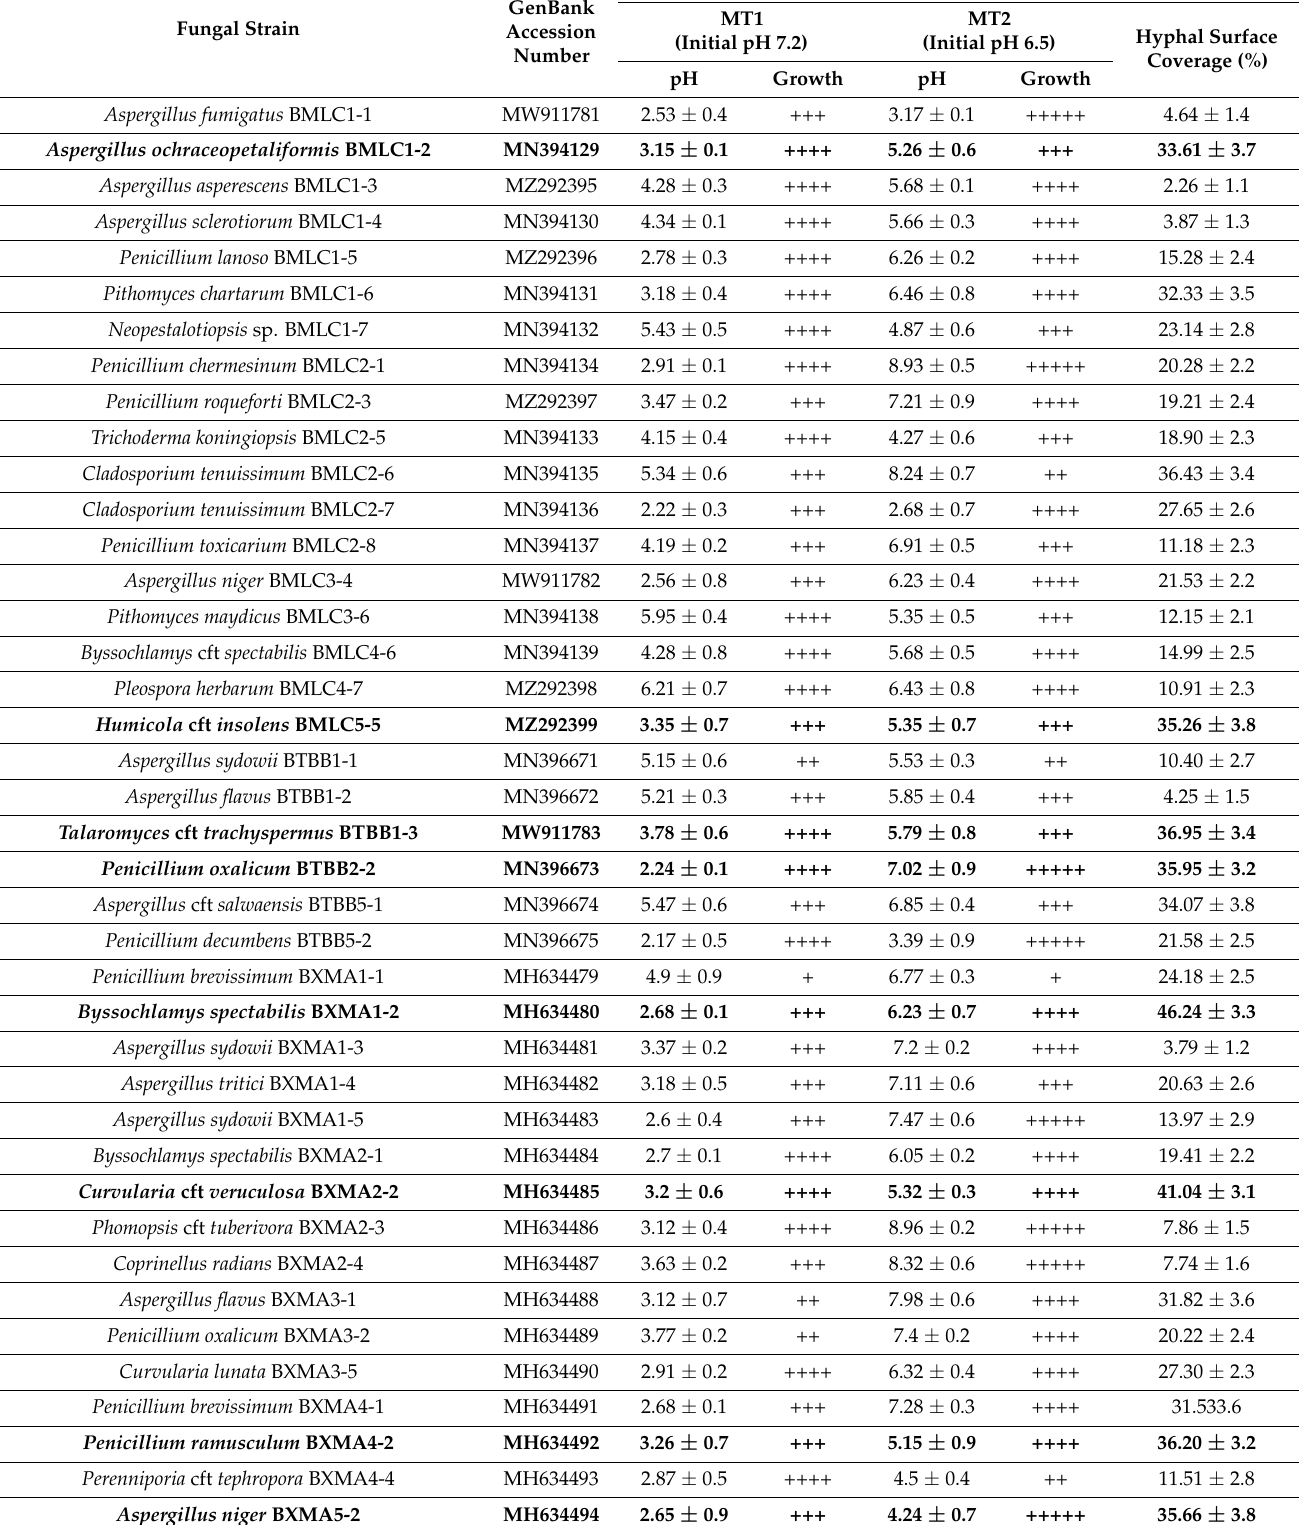
Table 2. Identification, the ability of growth and pH values observed in culture media, and percentage of hyphal surface coverage of isolated